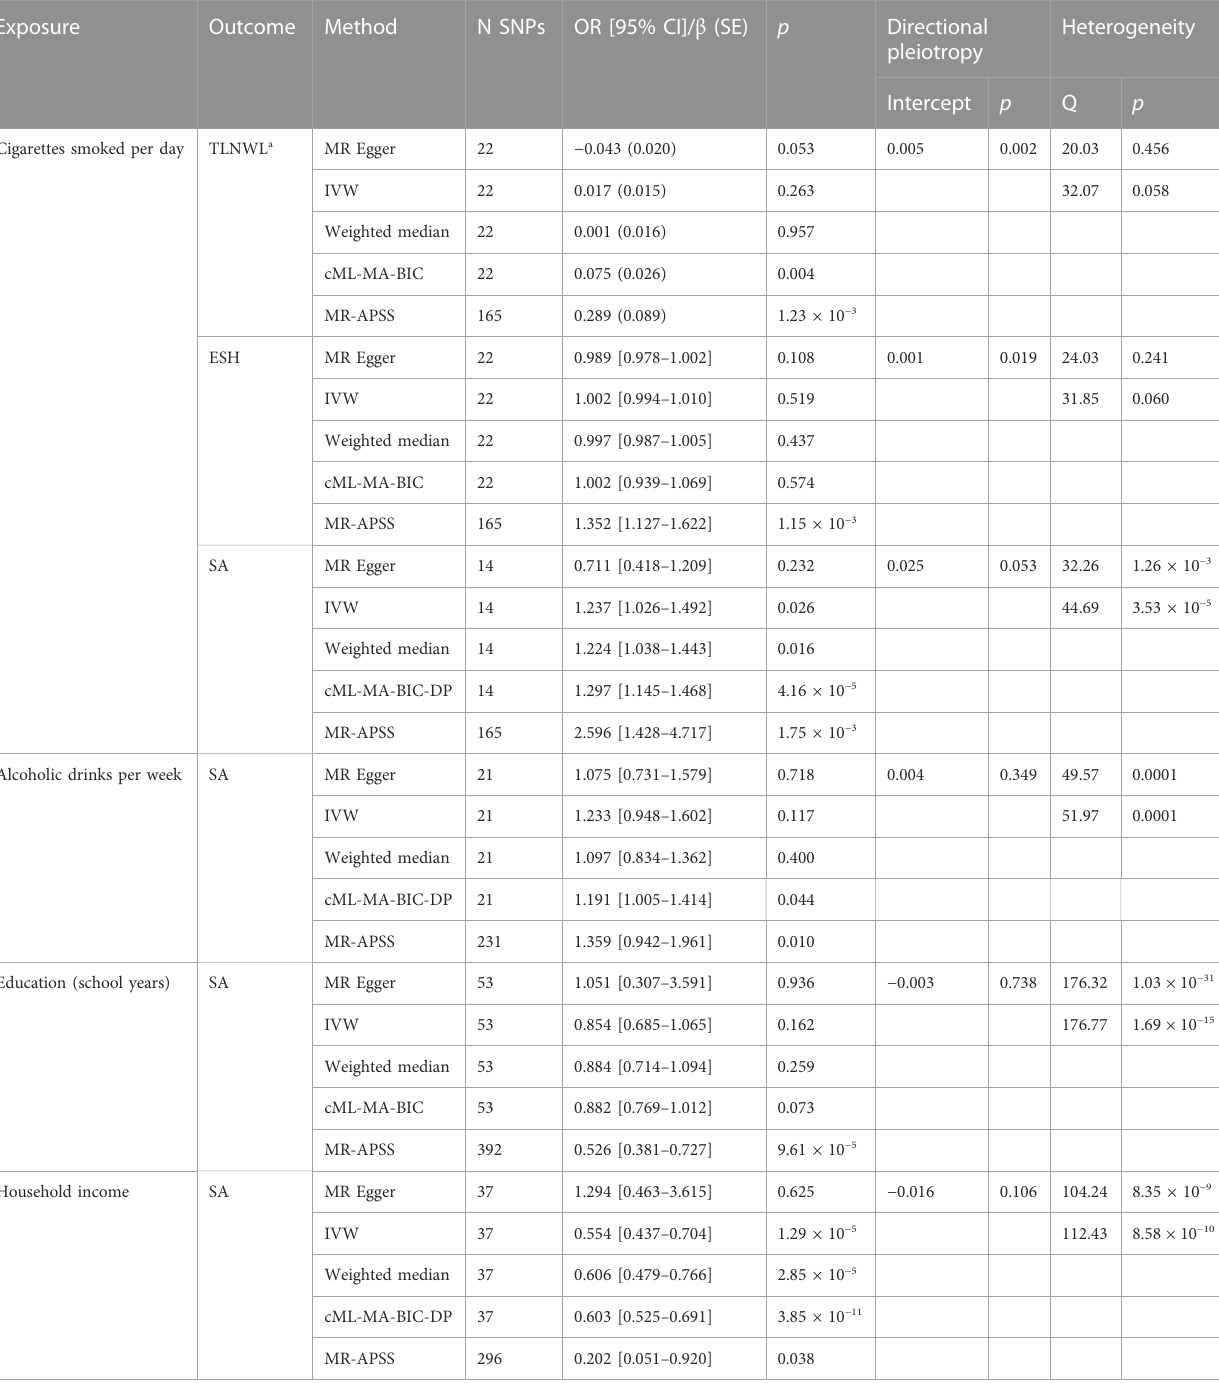
TABLE 5 Two-sample Mendelian Randomisation analysis of the effect of behavioural and socioeconomic-related traits on suicidal behaviour.